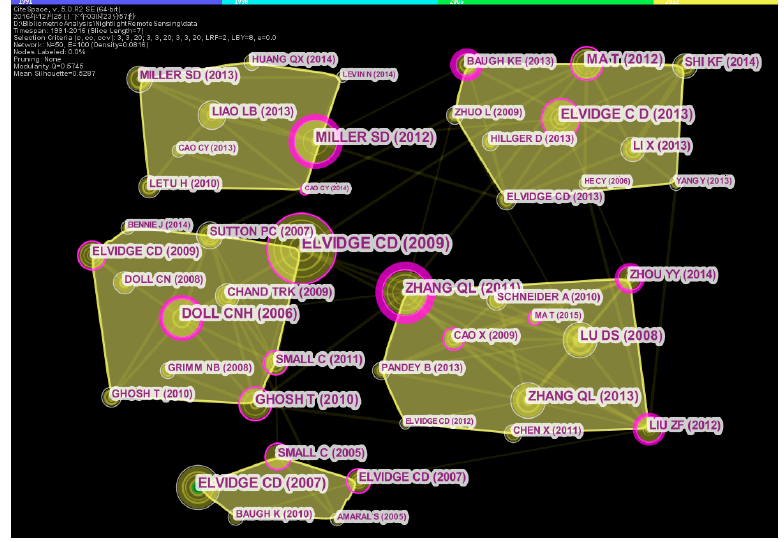
Figure 13. Co-cited reference map of the NTL remote sensing.